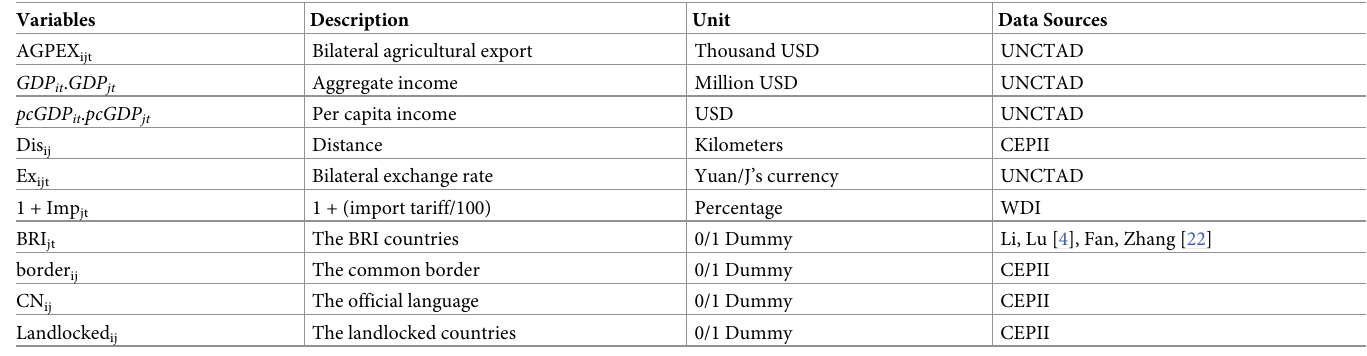
Table 2. Data sources of the variables used in this